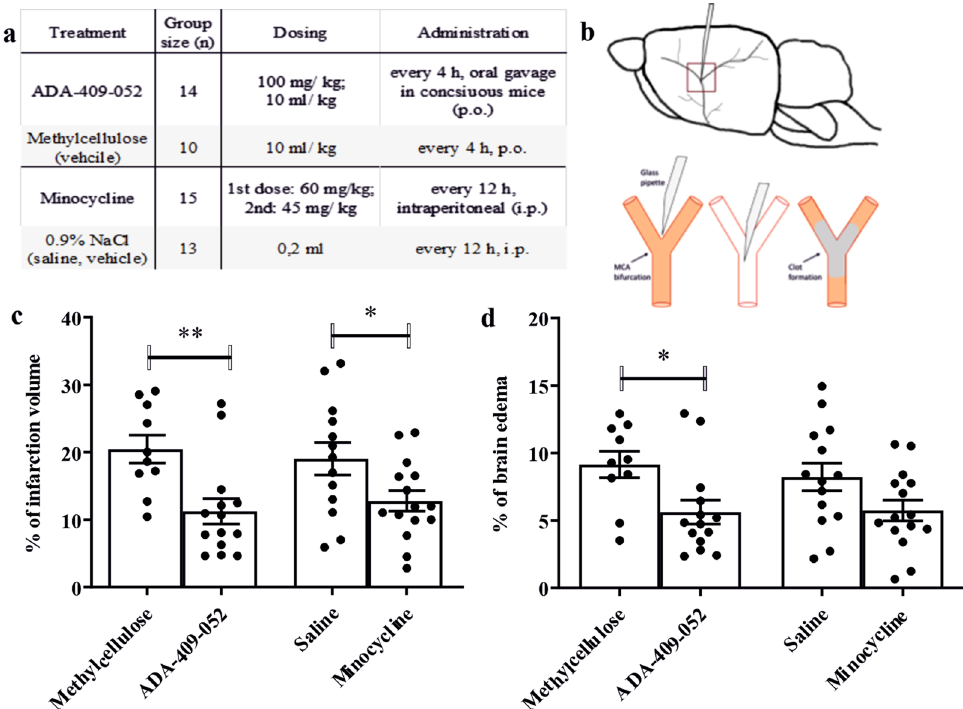
Figure 5. ADA-409-052 administration had a substantial neuroprotective effect in the TE-mouse model. The table (a) displays the group sizes, drug dosing and administration regime. ADA-409-052 was administered every 4 h, starting -1 h before TE-surgery, with 100 mg/kg at 10 ml/kg p.o. in conscious mice, methylcellulose was given accordingly. Minocycline was injected i.p. as a first dose of 60 mg/kg and a second dose of 45 mg/kg, every 12 h, whereas 0.2 ml of saline were injected i.p. to the vehicle group. Randomization was done using QuickCalcs (GraphPad Software). (b) shows a schematic drawing of the MCA-anatomy in the mouse brain, a magnified view below displays the inserted micropipette, and the in situ clot formation of the murine α-thrombin within the MCA (red box indicates the magnified area). (c,d) ADA-409-052 treatment significantly reduced infarct volume and brain edema in mice at 24 h post-ischemic stroke. Minocycline treatment, a competitor compound that was used as positive control, caused a significant reduction of the lesion volume. Of note, minocycline failed to reduce the edema size. Lesion and edema volume were assessed using T2-weighted MRI images and calculated according Shuaib’ s formula 77 . Values are presented as mean ± s.e.m.; unpaired, two-tailed student’s t-test; n = 10–15; *p < 0.05; **p <